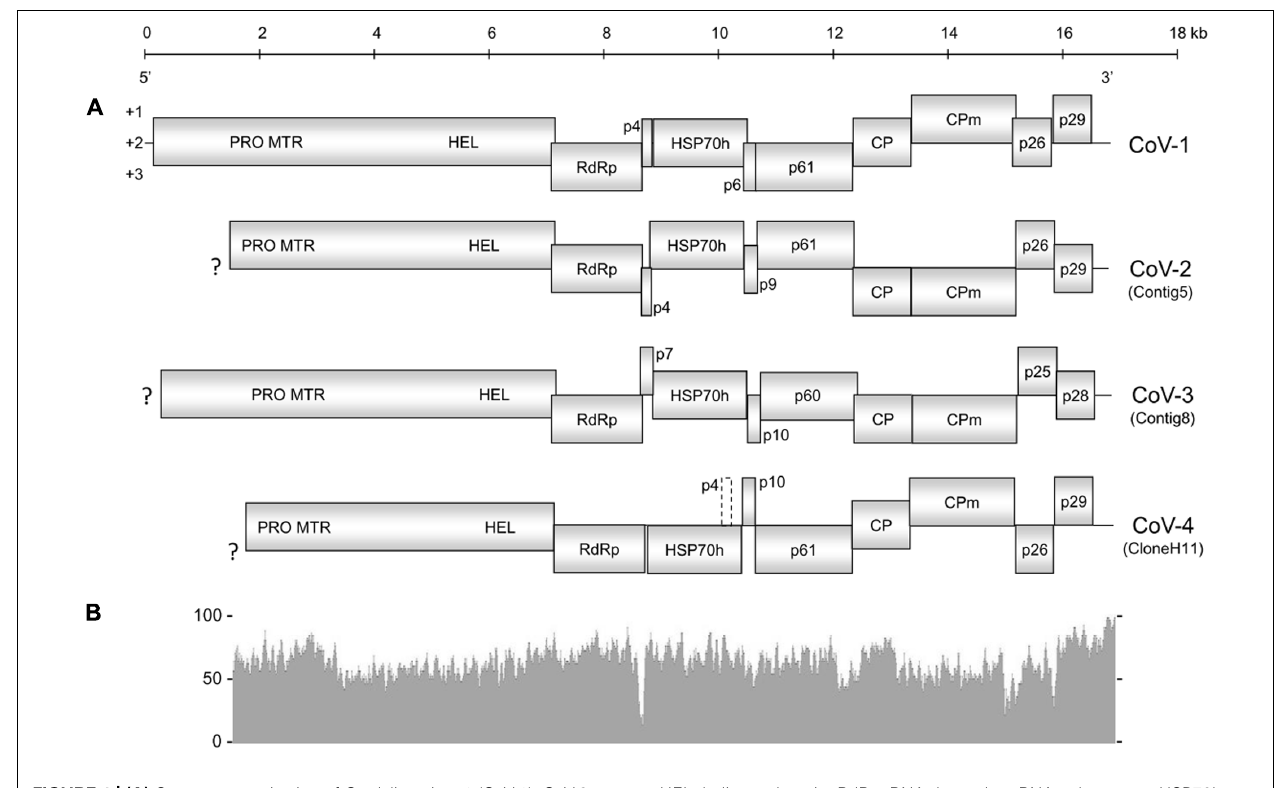
FIGURE 1 | (A) Genome organization of Cordyline virus 1 (CoV-1), CoV-2, CoV-3, and CoV-4. Solid boxes represent putative open reading frames (ORFs) with their vertical position indicating reading frame.The dashed box in CoV-4 represents a possible ORF that encodes a small hydrophobic protein within the HSP70h ORF. PRO, protease domain; MTR, methyltransferase domain;